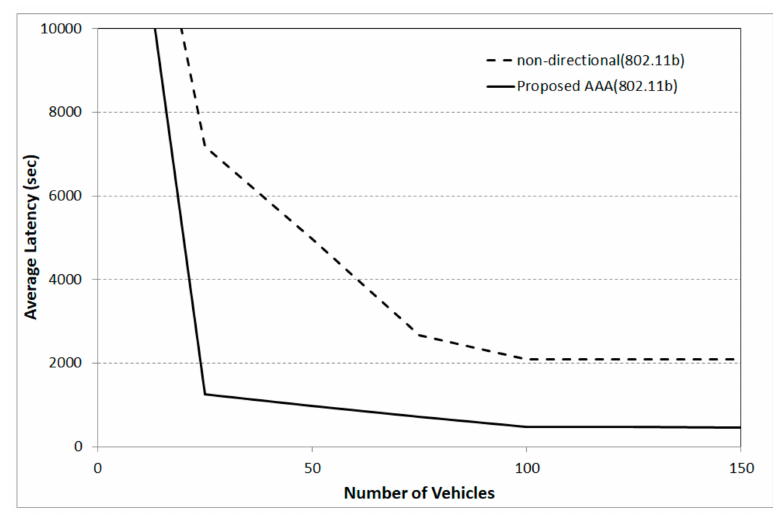
Figure 13. Results of the latency in the